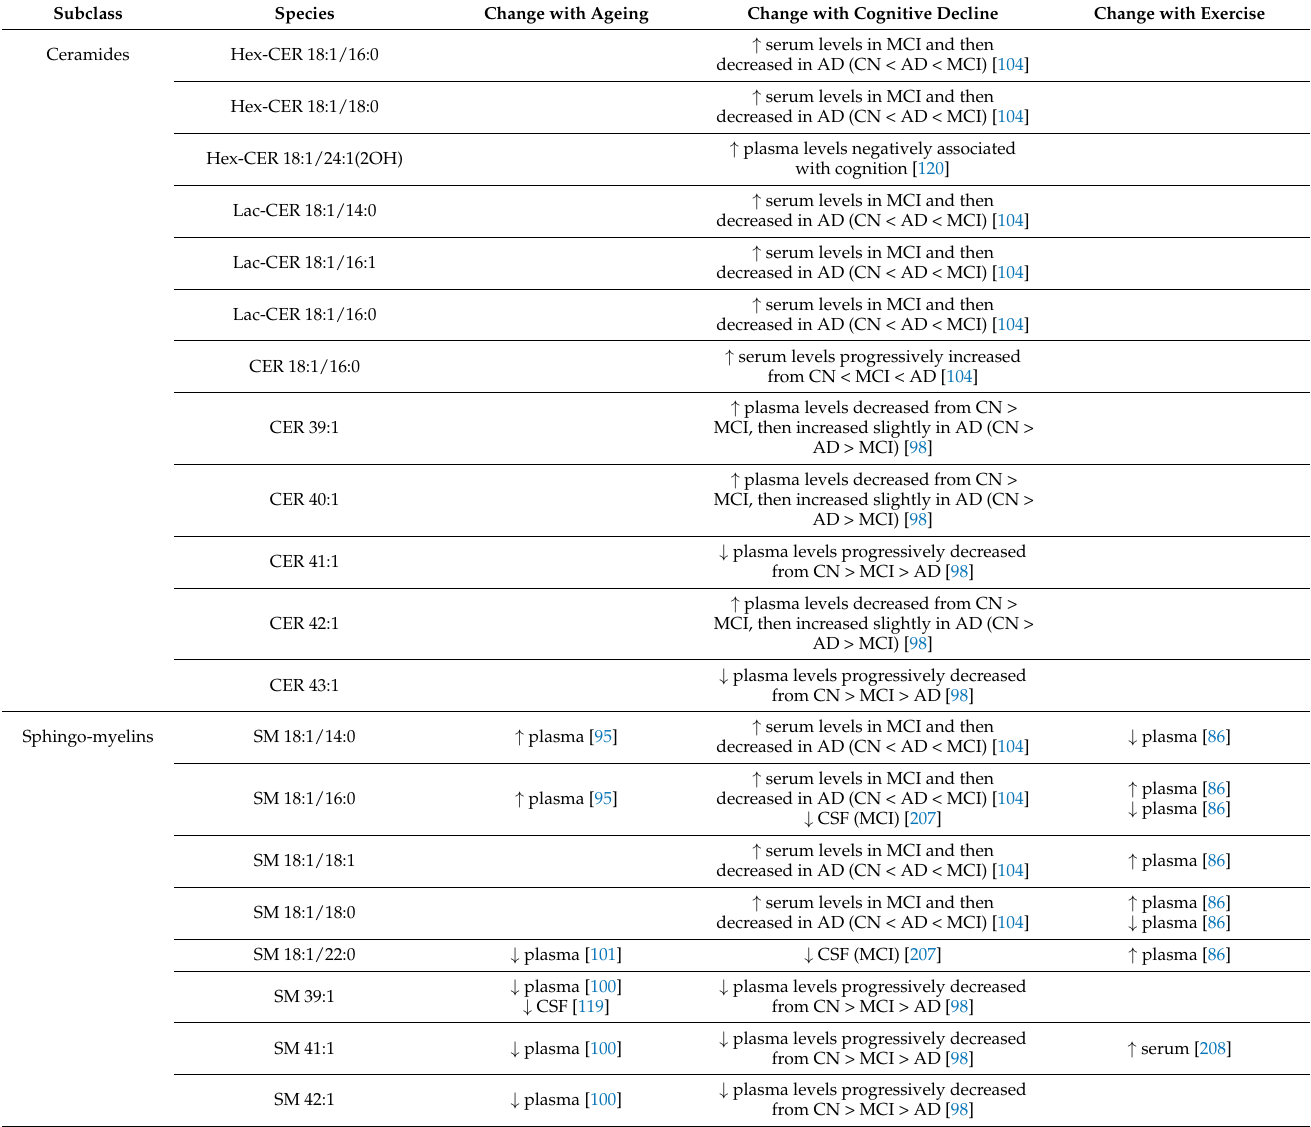
Table 4. Changes in sphingolipids with ageing, cognitive decline and exercise in humans. Subclass Species Change with Ageing Change with Cognitive Decline Change with Exercise